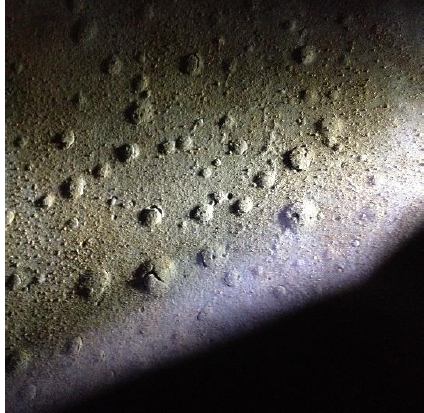
Figure 1. Blistering in internal surface.